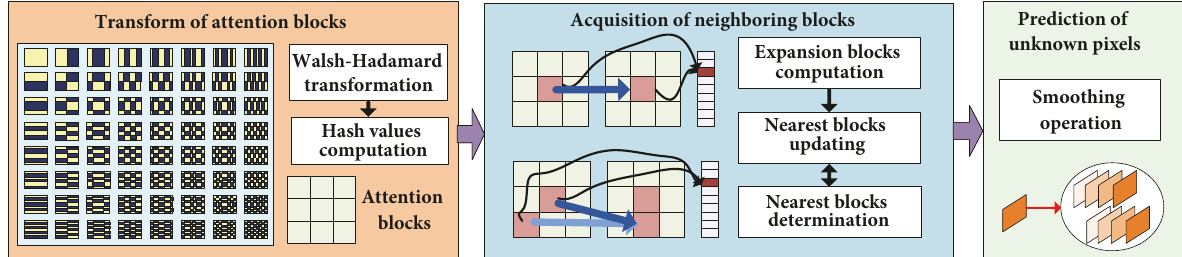
Figure 3: The computation of pixels in attention